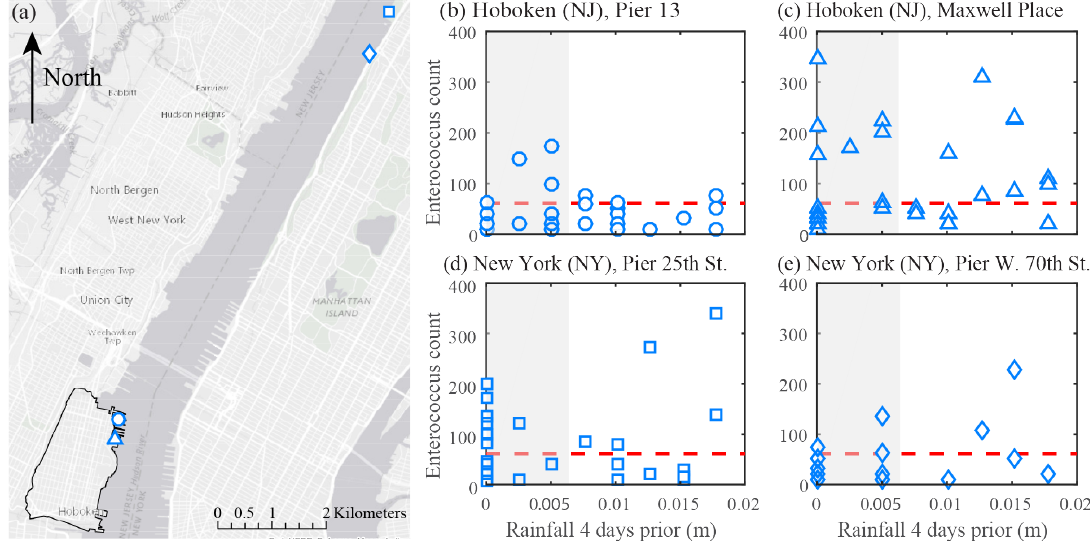
Figure 1. ( a ) Locations of water sampling along the Hudson River at four locations within the New York City metropolitan area; ( b – e ) FIB concentrations recorded between May 2014 and September 2016 [41]. The red line indicates the beach action value (BAV) concentration of 60 cells/100 mL of water, regulated by the U.S. EPA. The grey area in parts ( b ) through ( e ) indicates the dry-weather condition, i.e., rainfall less than 0.0063 m. The City of Hoboken is highlighted with a black